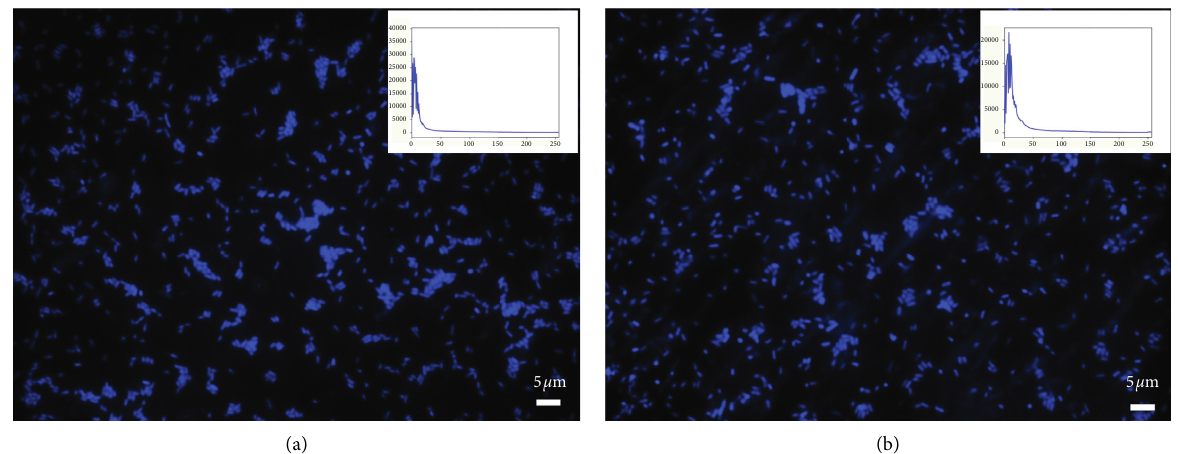
Figure 4: Effect of AgNPs in S. braenderup DNA integrity assessed by fluorescence microscopy with DAPI staining. In the presence of AgNPs, a concentration ratio of 1 :2 for 1hr (a) and 1 :2 for 2hrs (b).